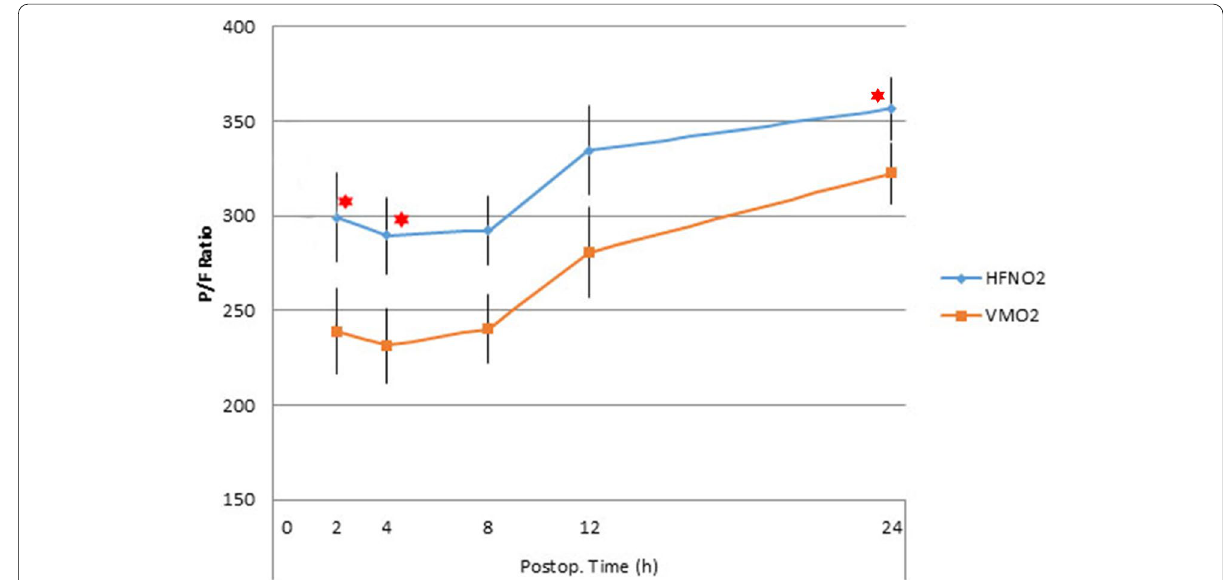
Fig. 4 PaO 2 /FiO 2 throughout the study time is significantly higher in the HFNO 2 group. The red marks mean that the p -value was found to be significant